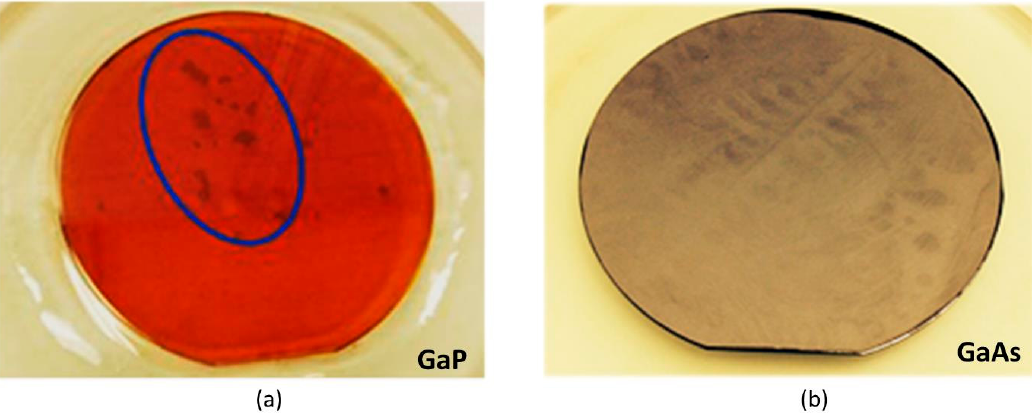
Figure 12. ( a ) Due to poor parallelism 2 two-inch bonded “on-axis” (100) GaP wafers indicate a large useless area of voids between the wafers; ( b ) Such a problem does not exist when 2 GaAs wafers are bonded [59]. (Reproduced from [59] with the permission of OSA).